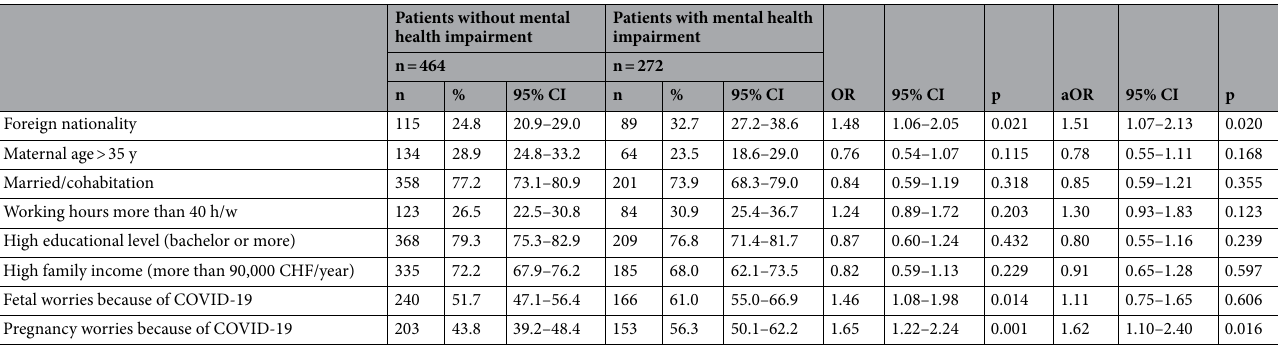
Table 3. Associations between mental health impairment and baseline characteristics as potential risk factors using a univariate and a multivariate logistic regression model. y: years; h/w: hours per week; OR: crude odd ratio; aOR: adjusted OR; Adjustment with all cofactors listed in the